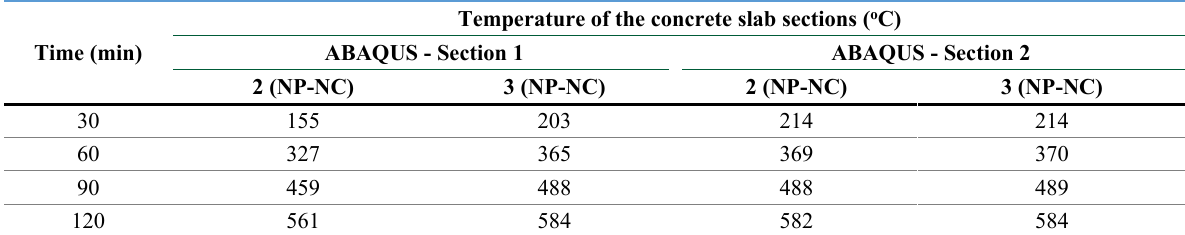
Table 5. Uniform temperature in the concrete slab sections of the composite beams 2 (NP-NC) and 3